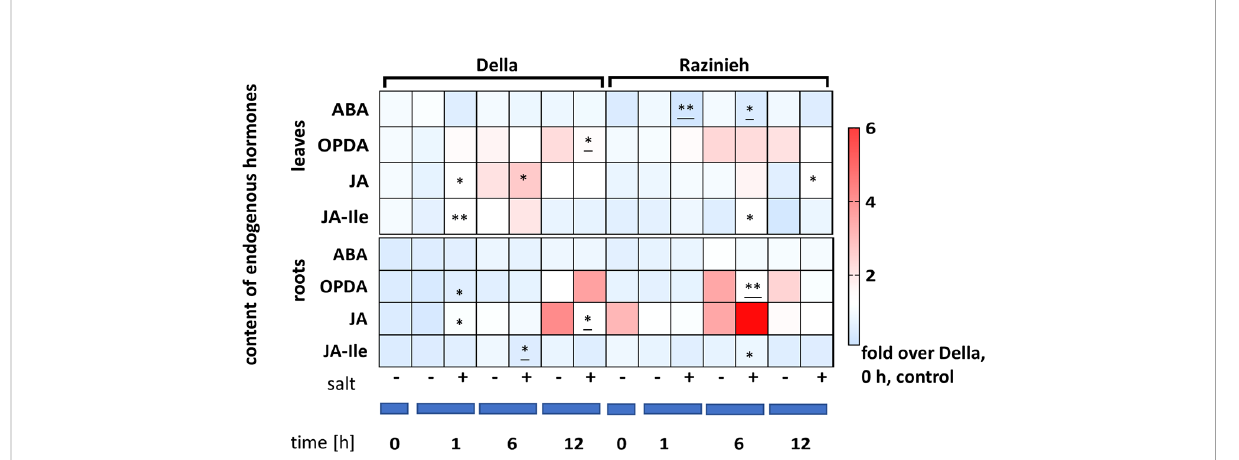
FIGURE 9 Heat maps representing the Log 2 fold change of endogenous hormones content compared to the control of Della at day 0 in roots and 2 nd leaves of Della and Razinieh seedlings treated with 100 mM NaCl for 1, 6, and 12 h. Values represent the mean of at least three independent biological replicates ± SE. Asterisks indicate a statistically signi fi cant difference between treatment and corresponding control, as determined by Student ’ s t -test (* P < 0.05, ** p < 0.01, and * signi fi cant